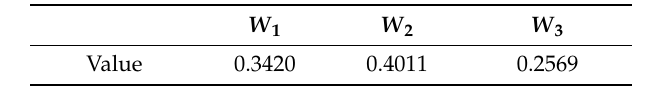
Table 2. Weights for